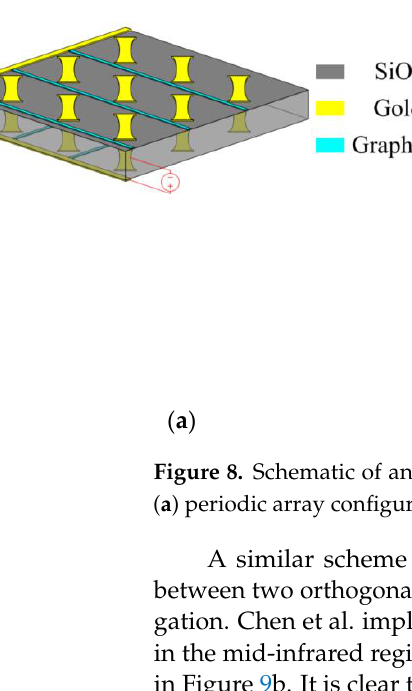
with an MS, as shown in Figure 9d. Meta transition for VO2 changes the operational fre- quency from 0.468 THz to 0.502 THz. MS performs transmissive linear to circular polari- zation conversion at two stated operational frequencies. They fabricated MS using pulsed laser deposition (PLD) on a c-cut sapphire substrate using a metallic vanadium target in an oxidizing background. Further, iron milling was used to pattern cross-shaped resona- tors. Figure 9e shows a resistive heater with a square aperture, which was milled at the center to vary the temperature controlled by an external voltage source. 6.3.3. Controllability Using Structural Change Several other controlling factors for LP-to-CP converters could be microfluidic MSs [112], as shown in Figure 10a; where, three different polarization states (LHCP, RHCP, LP) are obtained by microfluidic injection through different channels. Such a type of con- trol is very useful for applications requiring a large number of diodes as tunable or MSs [113]. As seen in Figure 10a, when microfluidic is injected into the upper channel only, the outgoing wave is LHCP and vice versa is done for RHCP.